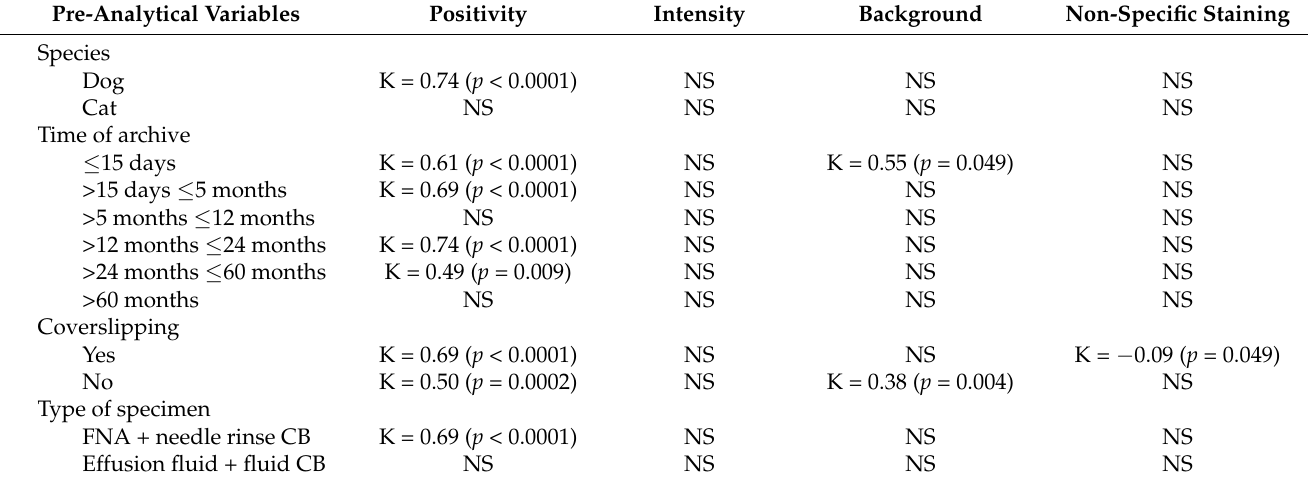
Table 4. Variation of the agreement (kappa values) of the parameters of the PAX5 immunolabeling applied to previous Romanowsky-stained cytology slides and of the PAX5 immunolabeling on cell blocks (as evaluated by a board-certified pathologist) according to the pre-analytical variables: species, time of the archive, coverslipping and type of specimen (NS non-significant).